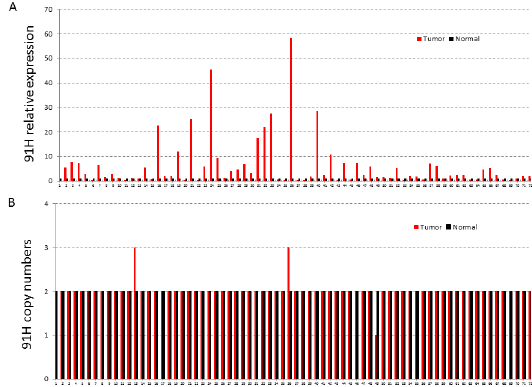
Figure 6. The relationship between copy number variation and 91H expression in tumor tissues and adjacent normal tissues. A, The 91H relative expression in matched cancerous and noncancerous tissues was measured by qRT-PCR. b -actin was considered as the internal control. B, The copy number variation of 91H in cancerous and noncancerous tissues was also measured by qRT-PCR. RNase P was used as a reference gene.